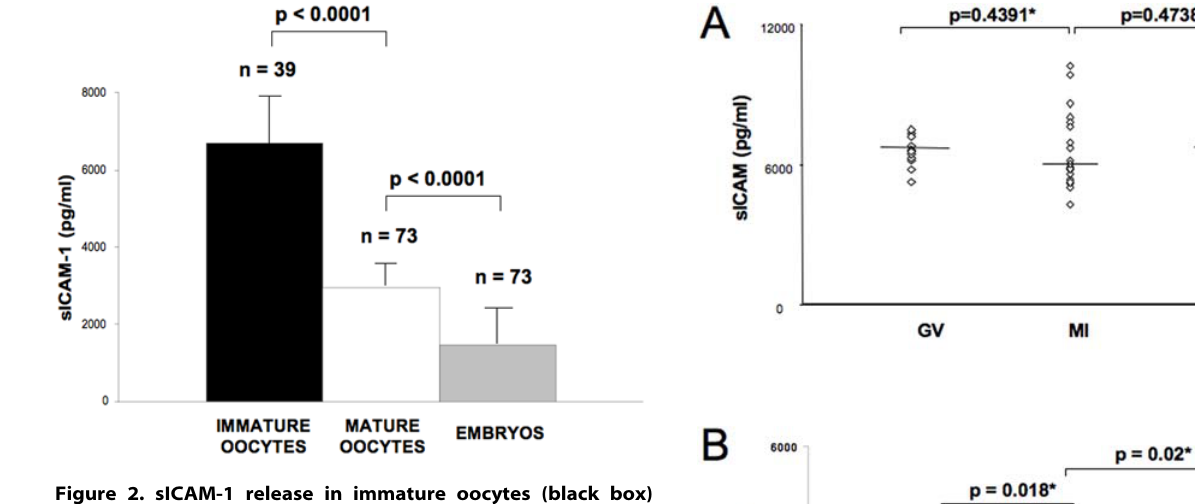
Figure 2. sICAM-1 release in immature oocytes (black box) compared to mature (white box) oocytes and to in vitro fertilized embryo (grey box). Oocytes were individually cultured in a 4-well culture dish as reported in the methods section. Following the maturation period 250 m l of supernatants were collected from each culture system and stored at 2 20 u C until being tested for the presence released proteins. Mature and immature oocytes were identified, one by one, evaluating the presence or absence of the first polar body. In vitro fertilized embryos were individually cultured in 4-well culture dishes and 250 m l of supernatants collected from each embryo culture and stored at 2 20 u C until being tested for the presence of released proteins. * Student t Test.